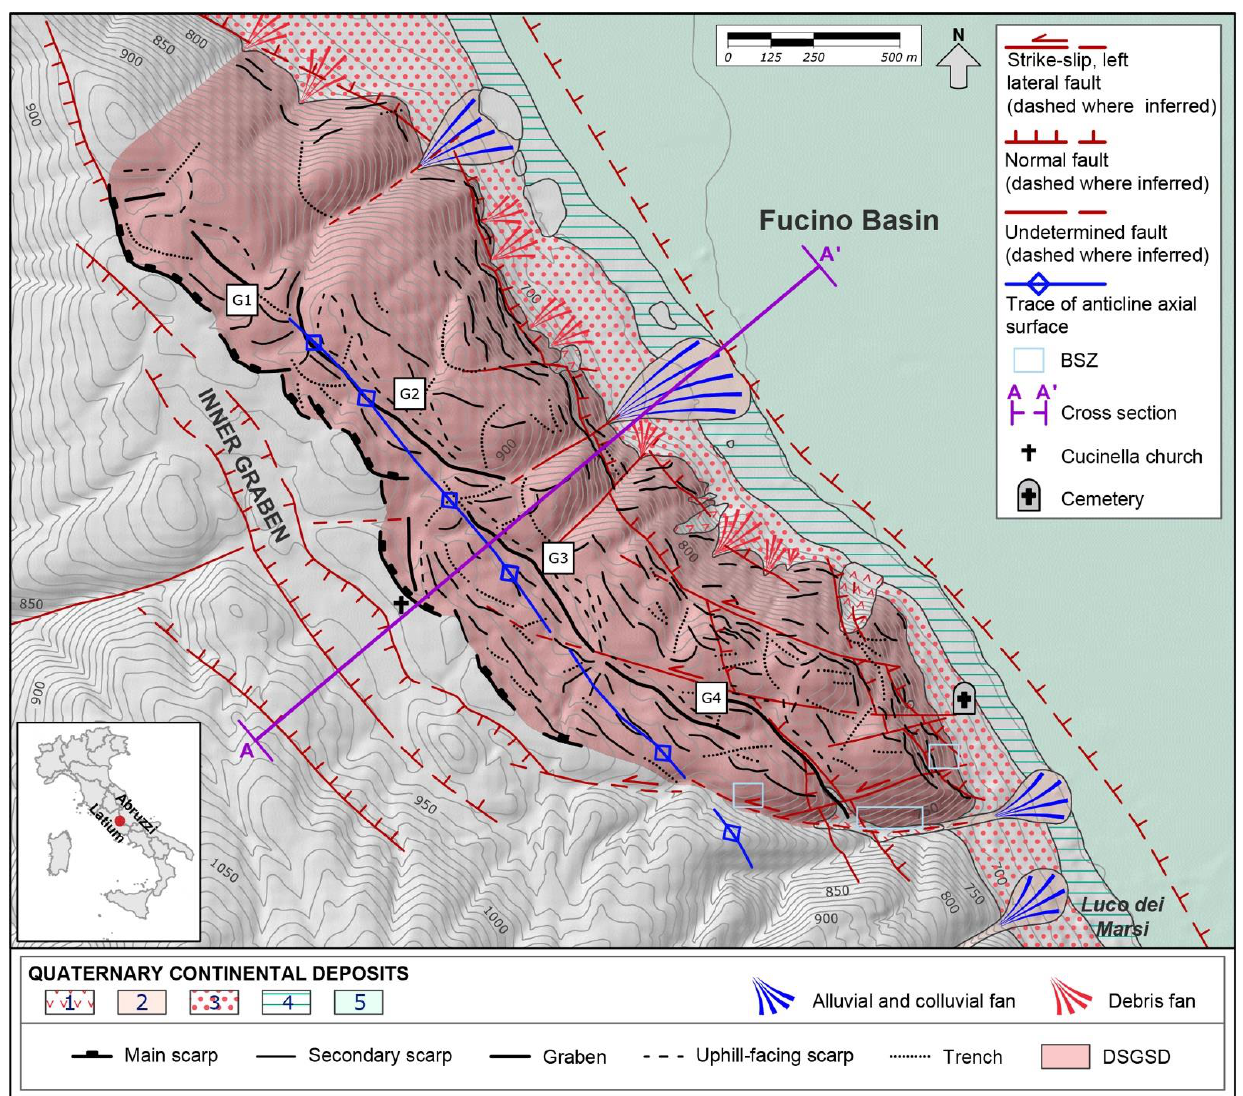
Figure 5. Inventory map of geomorphological features ascribable to the Luco dei Marsi DSGSD and location of the BSZ outcrops along the southern edge, modified after Di Luzio et al. [39]. Structural and tectonic elements from Figure 2 are reported. Quaternary deposits: (1) landslides; (2) residual clay deposits; (3) talus slope deposits; (4) eluvial-colluvial deposits; (5) alluvial and lacustrine deposits of the Fucino Basin. G1–G4 = gravitational grabens.